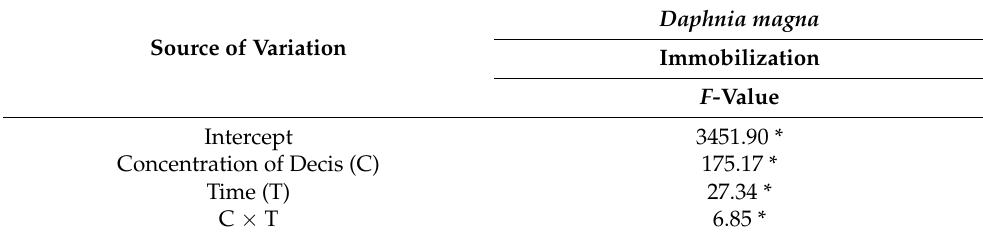
Table 4. Analysis of variance (ANOVA) for immobilization of Heterocypris incongruens exposed to Decis ® 2.5